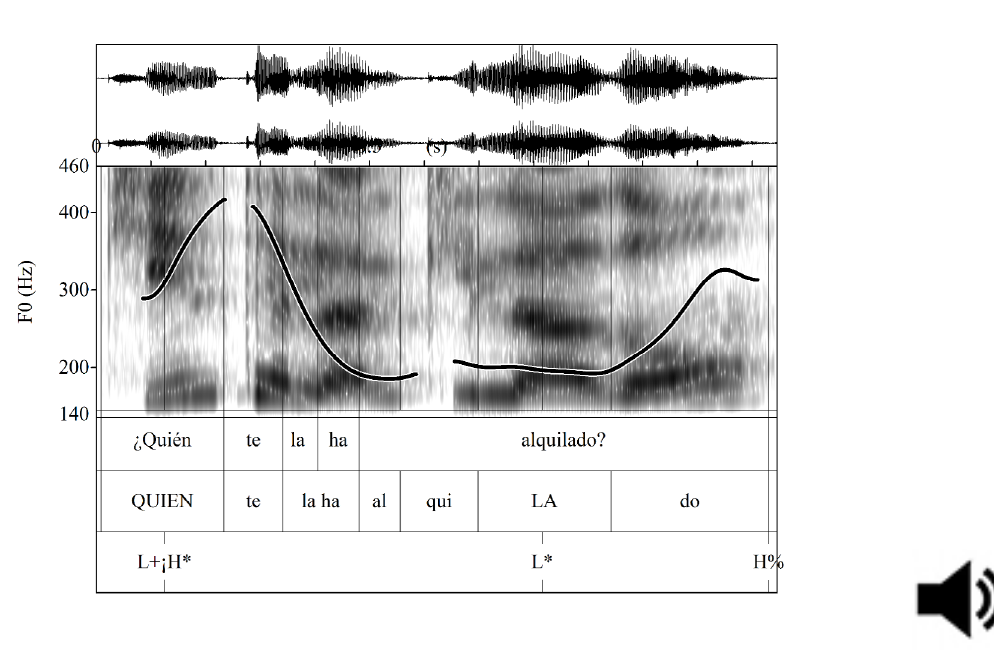
Figure 20 (Participant 13): Waveform and F0 trace for the neutral wh- question ¿Quién te la ha alquilado? ‘Who has rented you the house?’ produced as L+¡H* (in prenuclear position) and as L* H% (nuclear